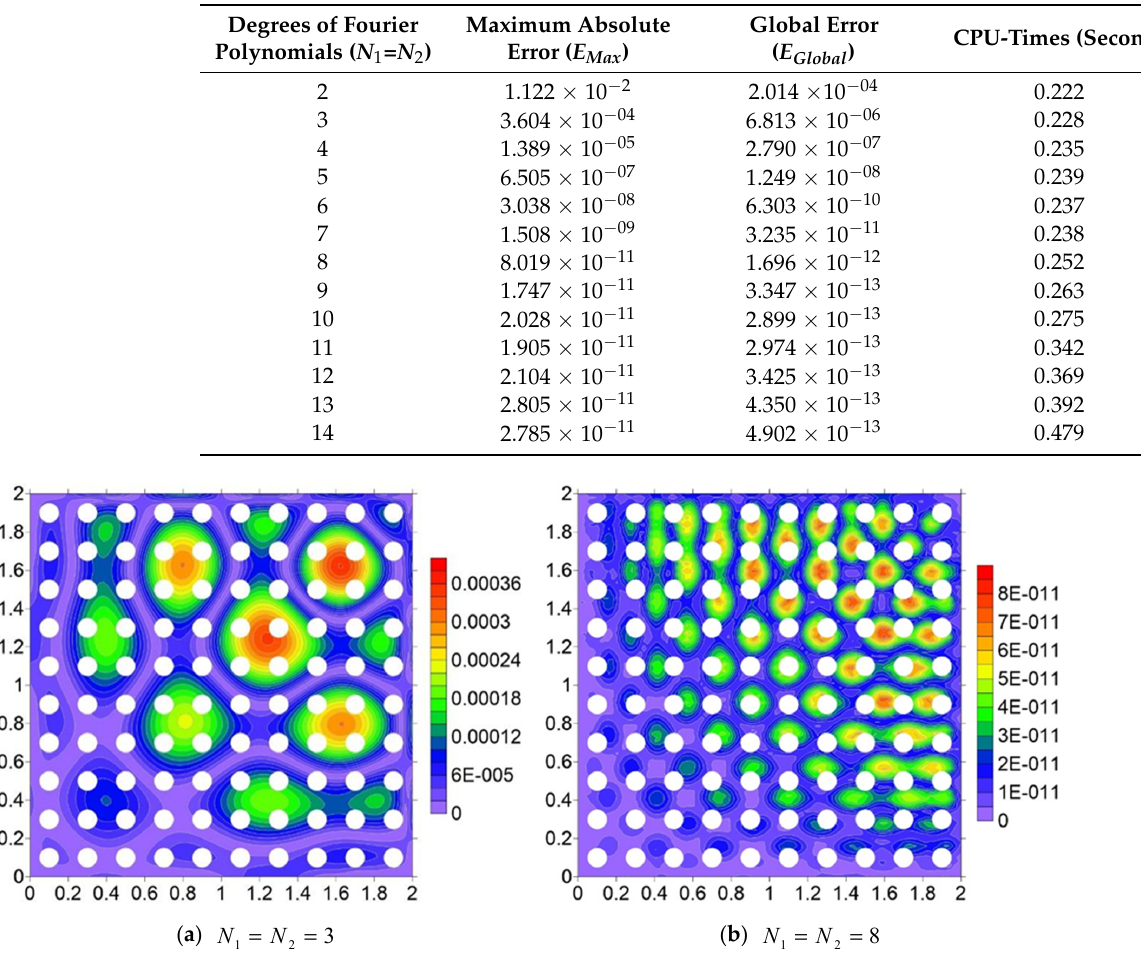
Figure 7. Relative error distribution of the calculated temperatures u ( x 1 , x 2 ) , where the degrees of Fourier polynomials are ( a ) N 1 = N 2 = 3 and ( b ) N 1 = N 2 =